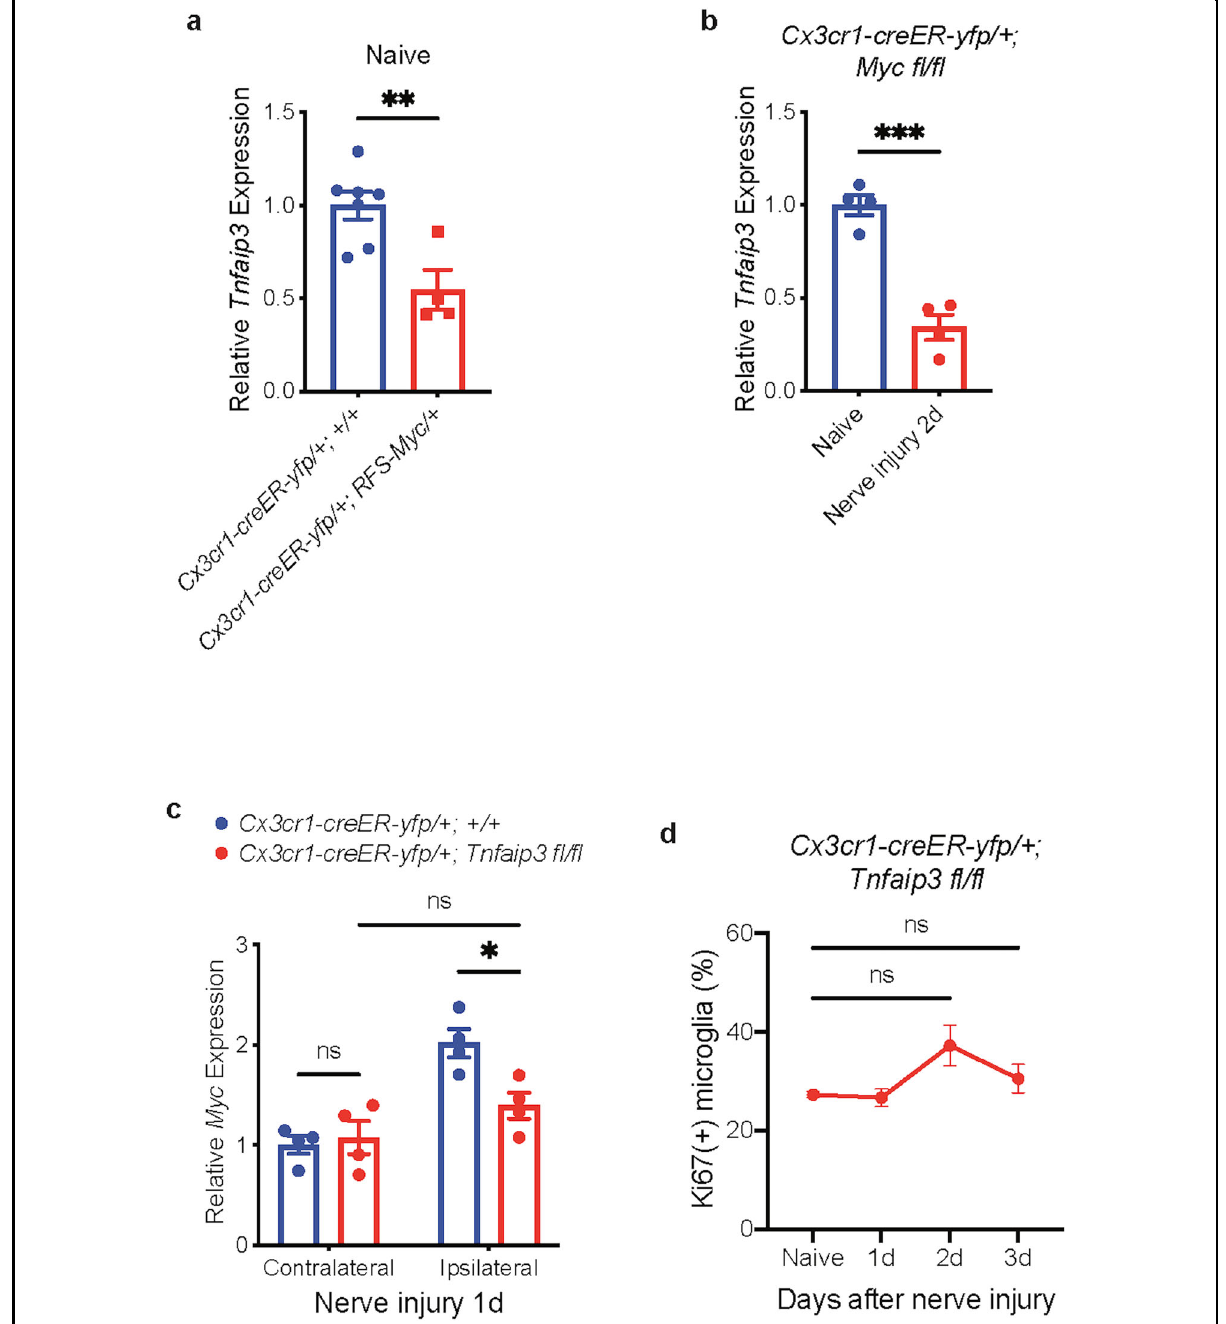
Fig. 6 Interaction between Myc upregulation and Tnfaip3 downregulation in microglia. a qRT-PCR of sorted lumbar cord microglia. Overexpression of Myc in microglia of adult naive Cx3cr1-creER-yfp/ + ; RFS-Myc/ + animals resulted in downregulation of Tnfaip3 . b qRT-PCR of sorted lumbar cord microglia from Cx3cr1-creER-yfp/ + ; Myc fl / fl cKO animals. Deletion of Myc from adult microglia did not prevent Tnfaip3 downregulation 2 days after nerve injury. c qRT-PCR of sorted lumbar cord microglia. Deletion of Tnfaip3 from adult microglia prevented Myc upregulation 1 day after nerve injury. d Quanti fi cation of Ki67 fl ow cytometry. The proliferation of lumbar cord microglia in Cx3cr1-creER-yfp/ + ; Tnfaip3 fl / fl cKO animals did not increase after nerve injury. Analyses are unpaired two-tailed t -test ( a , b ) and one-way ANOVA with Tukey ’ s multiple-comparison test ( c , d ), n = 4 – 6, means ± SEM, * P < 0.05, ** P < 0.01, *** P < 0.001; ns, not signi fi